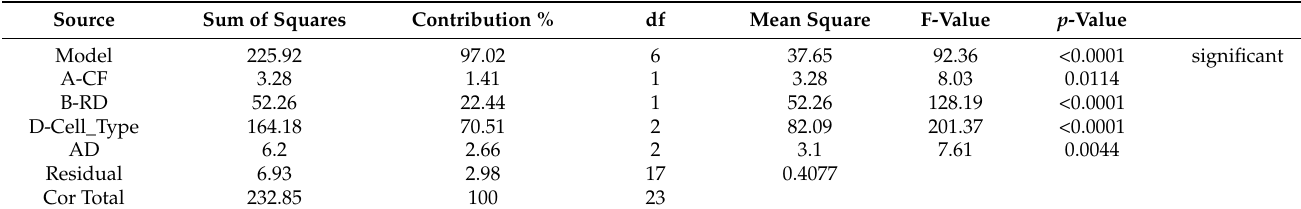
Table 7. Reduced ANOVA Table of SEA.